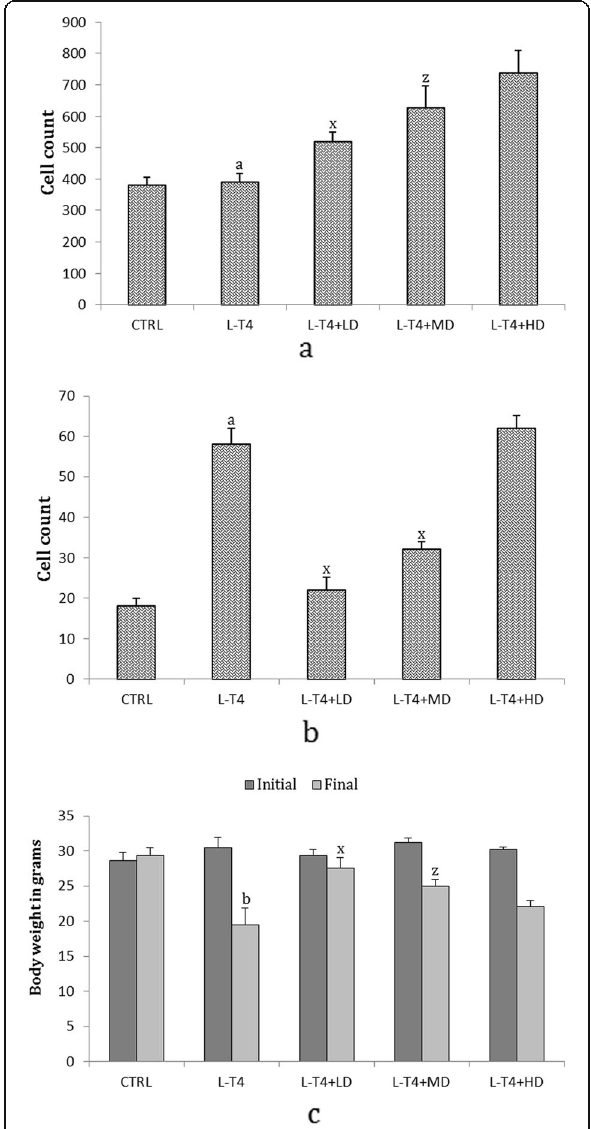
Fig. 2 a Effects of ACC on the number of hepatocytes counts in mice with T 4 -induced thyrotoxicosis. Each bar represents the mean ± s.e.m., n = 7. Ctrl, Control; T 3 , triidothyronine; T 4 , thyroxine. a P < 0.001 as compared to the respective control values. x P < 0.001 and z P < 0.05 as compared to the respective values of L-T 4 treated animals. b Effects of ACC on the number of inflammatory cell counts in mice with T 4 -induced thyrotoxicosis. Each bar represents the mean ± s.e.m., n = 7. Ctrl, Control; T 3 , triidothyronine; T 4 , thyroxine. a P < 0.001 as compared to the respective control values. x P < 0.001as compared to the respective values of L-T 4 treated animals. c Effects of the test compound, ACC on body weight, in hyperthyroid mice. Each bar represents the mean ± s.e.m., n = 7. b P < 0.01 as compared to the respective control values. x P < 0.001and z P < 0.05 as compared to the respective values of L-T 4 treated